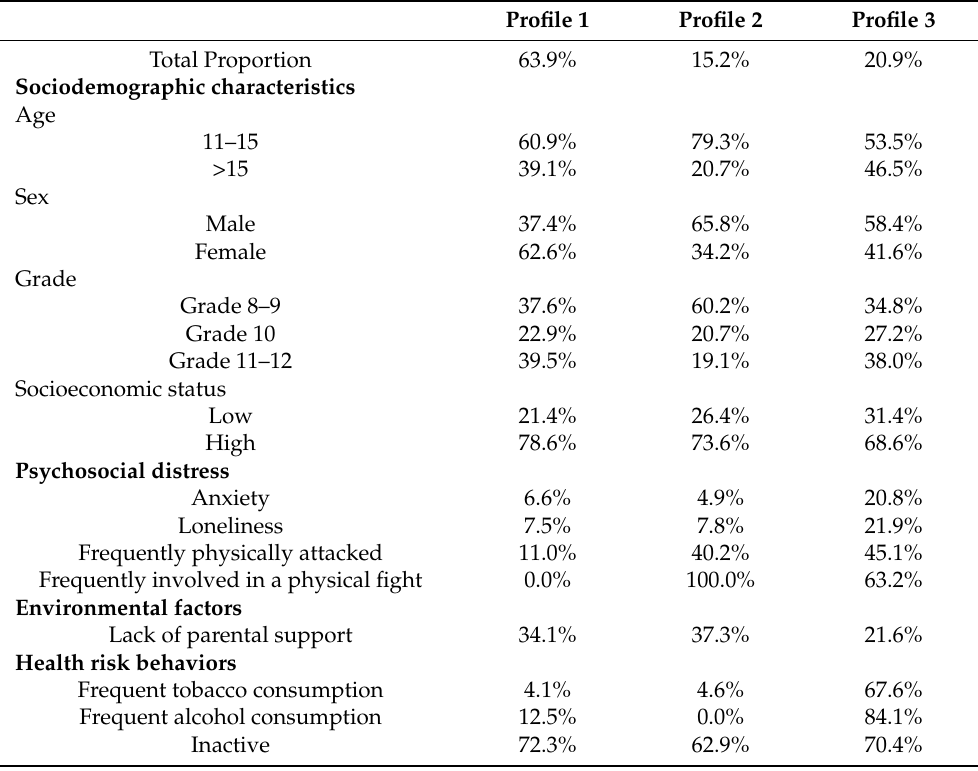
Table 4. Characteristics of the profiles obtained in adolescents aged 11–18 in Mauritius,